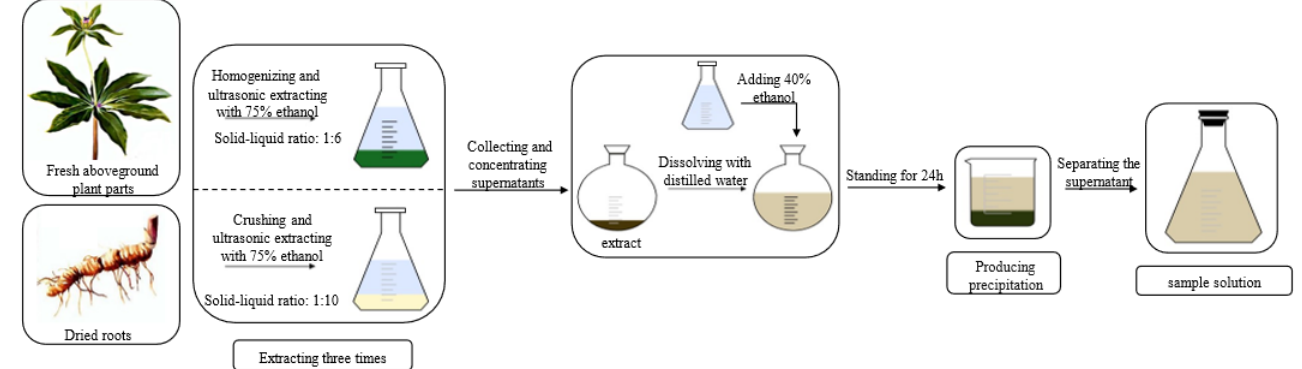
Figure 2. Experimental scheme for extraction of polyphyllin II and polyphyllin VII.